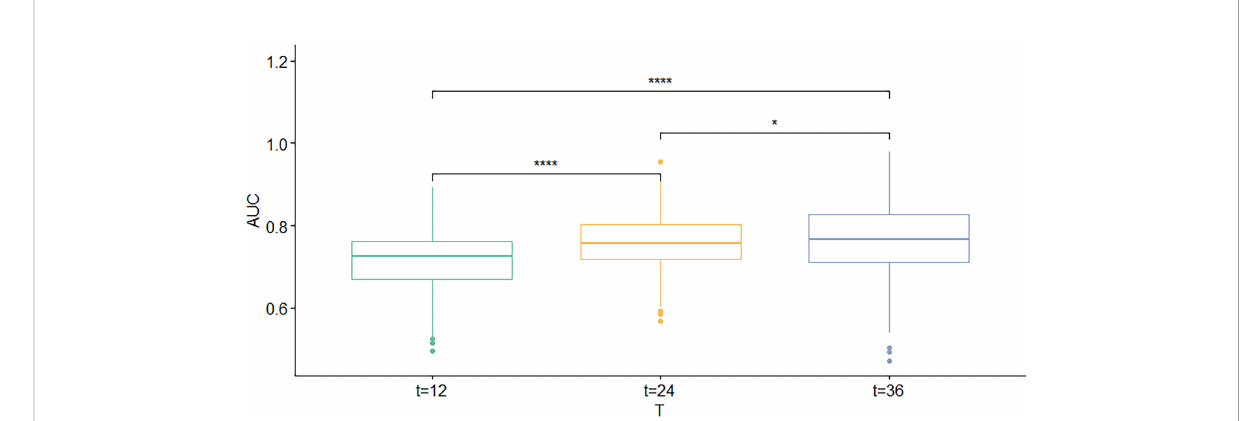
FIGURE 4 Box map: AUC mean value of 1-, 2-, and 3-year survival probability.